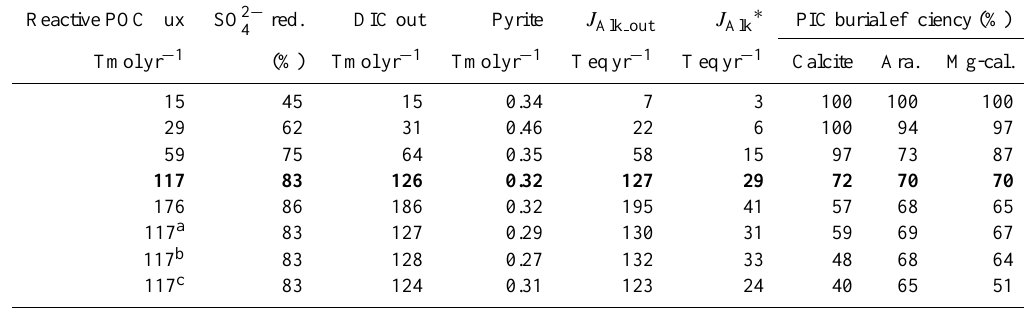
Table 8 . Global estimated benthic fluxes and PIC burial efficiency; POC, DIC and PIC sensitivity. Reactive POC flux SO 2 − red. DIC out Pyrite J Alk out 4